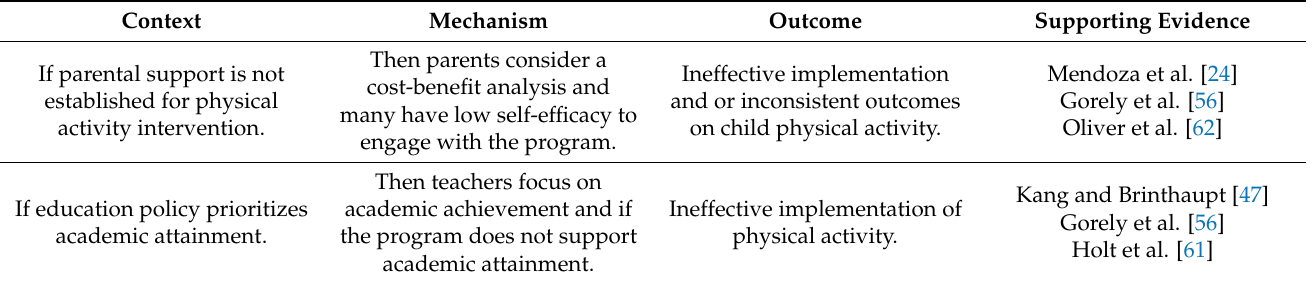
Table 4. Community and policy level of a conceptual framework for School-Based Physical Activity Interventions in Children Aged 7–11 Years of program theories